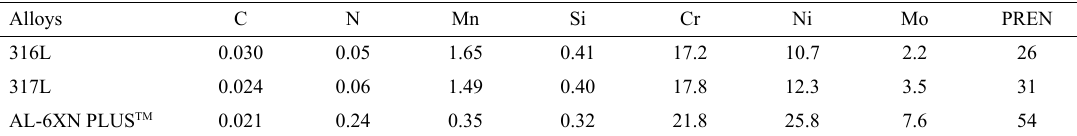
) of the studied alloys (wt%). N